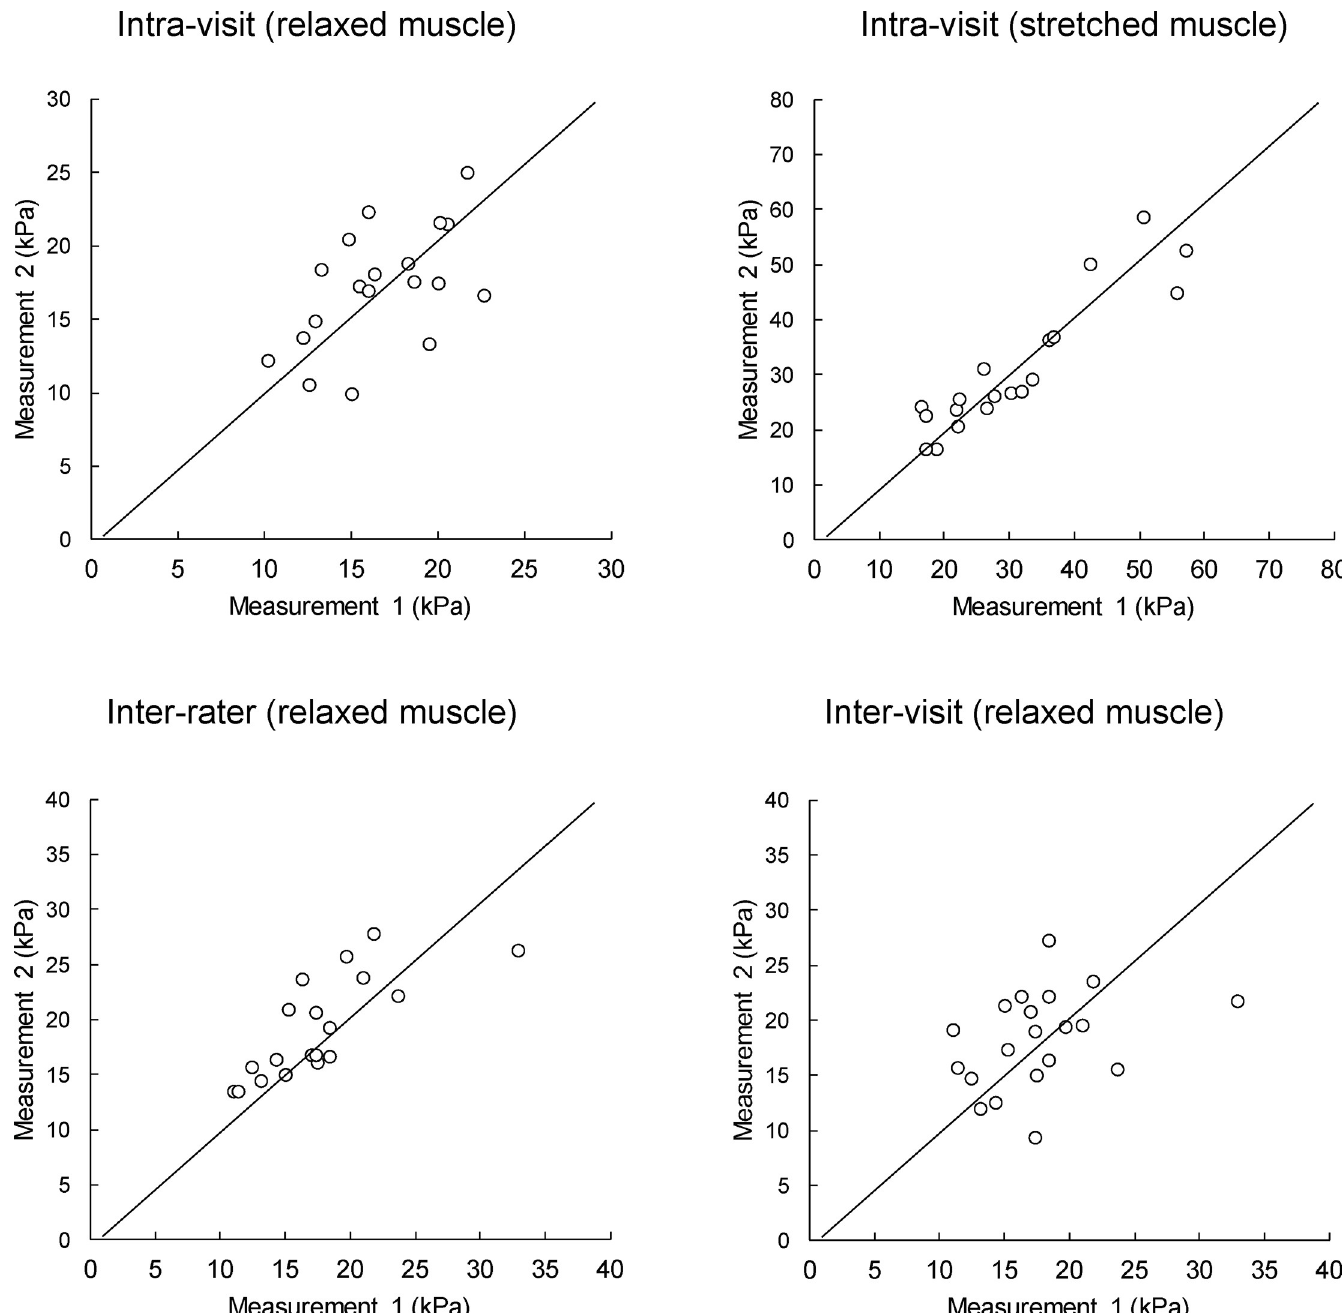
Fig 4. Scatter plots of measurements conducted by human examiners. Diagonal line represents a perfect match between two